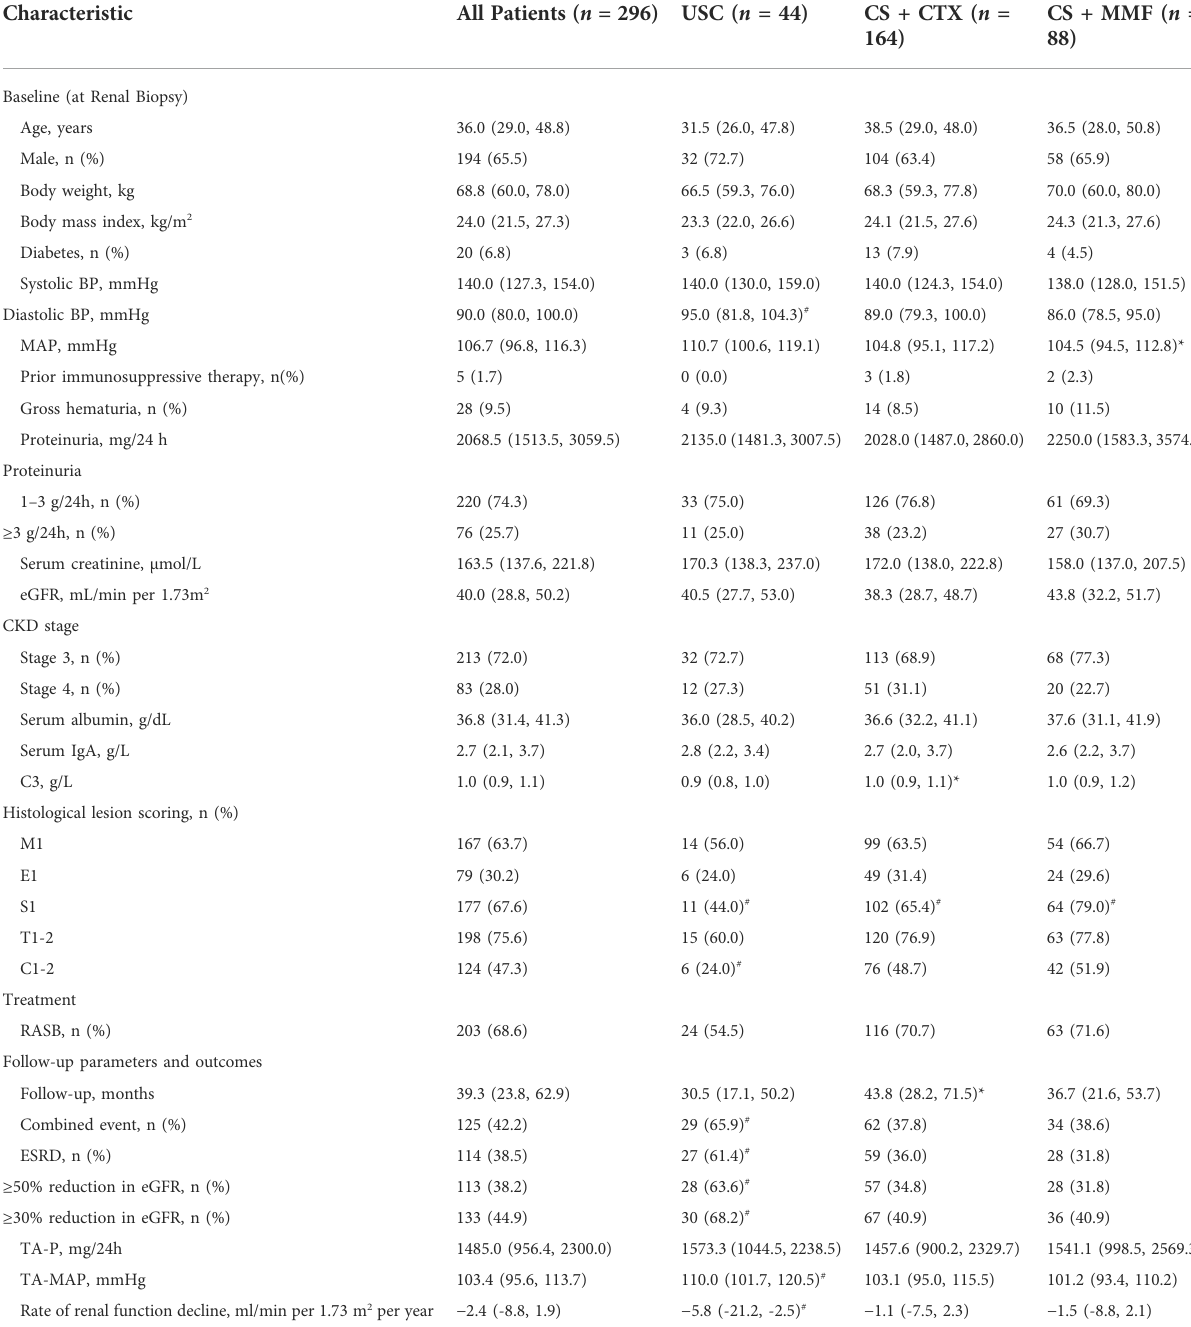
TABLE 1 Baseline and follow-up characteristics of the study subjects.